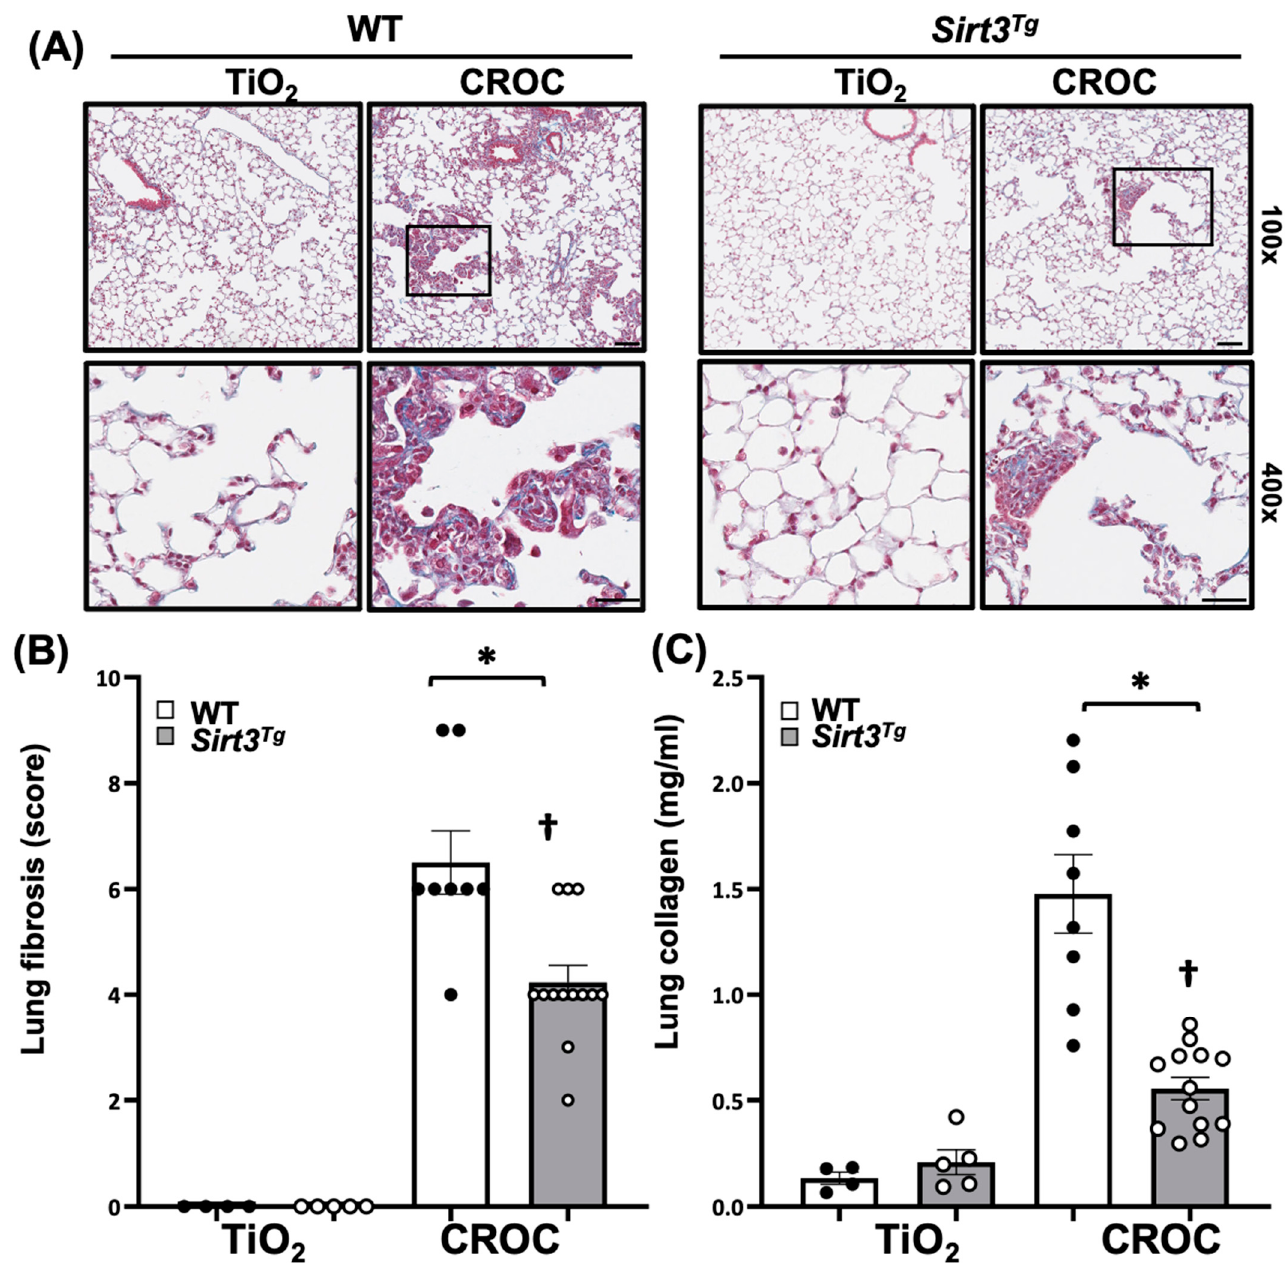
Figure 1. Sirt3 Tg mice are protected against asbestos-induced pulmonary fibrosis. Wild-Type (WT) and Sirt3 Tg mice were harvested 21 days after treatment with a single IT (intratracheal) instillation of crocidolite asbestos or titanium dioxide (TiO 2 ) control (100 µg in 50 µL). The extent of fibrosis was determined on day 21 in mouse lung by trichrome staining ( A ), lung fibrosis score ( B ), and collagen levels assessed by a Sircol assay ( C ). n = 4–13; * p < 0.05 vs. Ti; † p < 0.05 vs. WT. Scale bars = 100× = 0.1 mm; 400× = 0.05 mm.